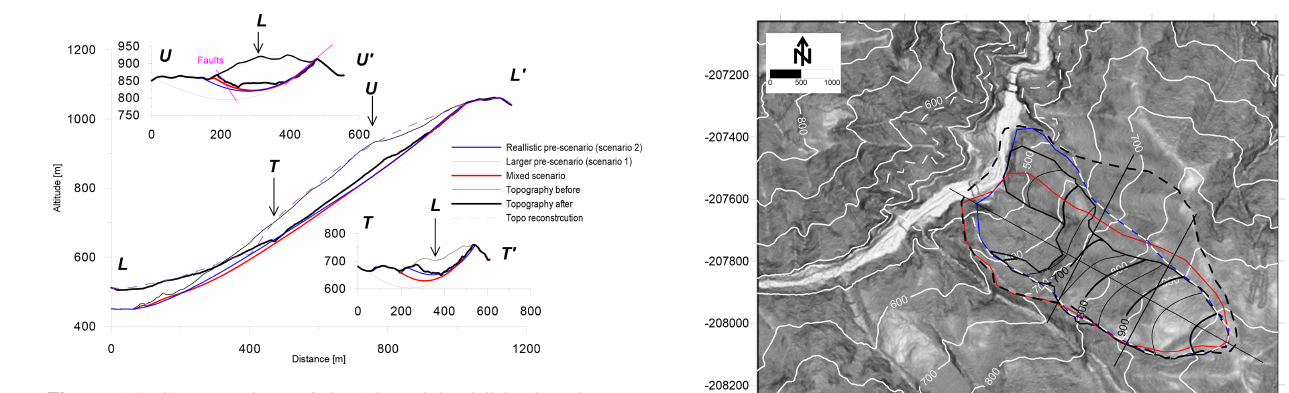
Figure 14. Cross sections of the Akatani landslide (locations are indicated in Fig. 13). The different scenarios indicated in profile U − U (cid:48) include a profile of the extreme scenario.